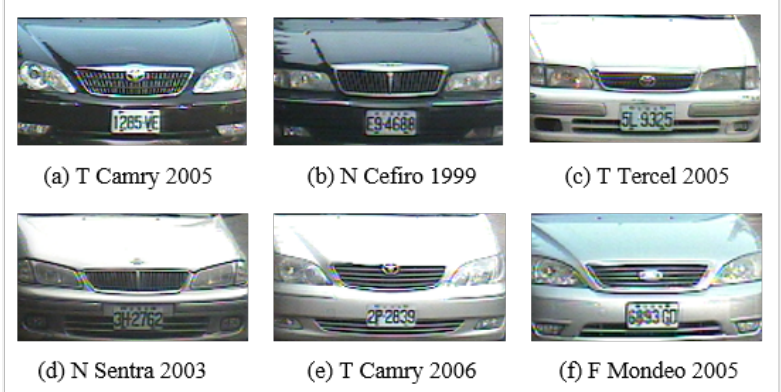
Figure 3. Inter-make ambiguity problems between ( a ) Toyota Camry 2005 and ( b ) Nissan Cefiro 1999; ( c ) Toyota Tercel 2005 and ( d ) Nissan Sentra 2003; and ( e ) Toyota Camry 2006 and ( f ) Ford Mondeo 2005 in the NTOU-MMR dataset. The inter-make ambiguity problem refers to the case where different vehicles (models) manufactured by different companies (makes) can have comparable appearances or